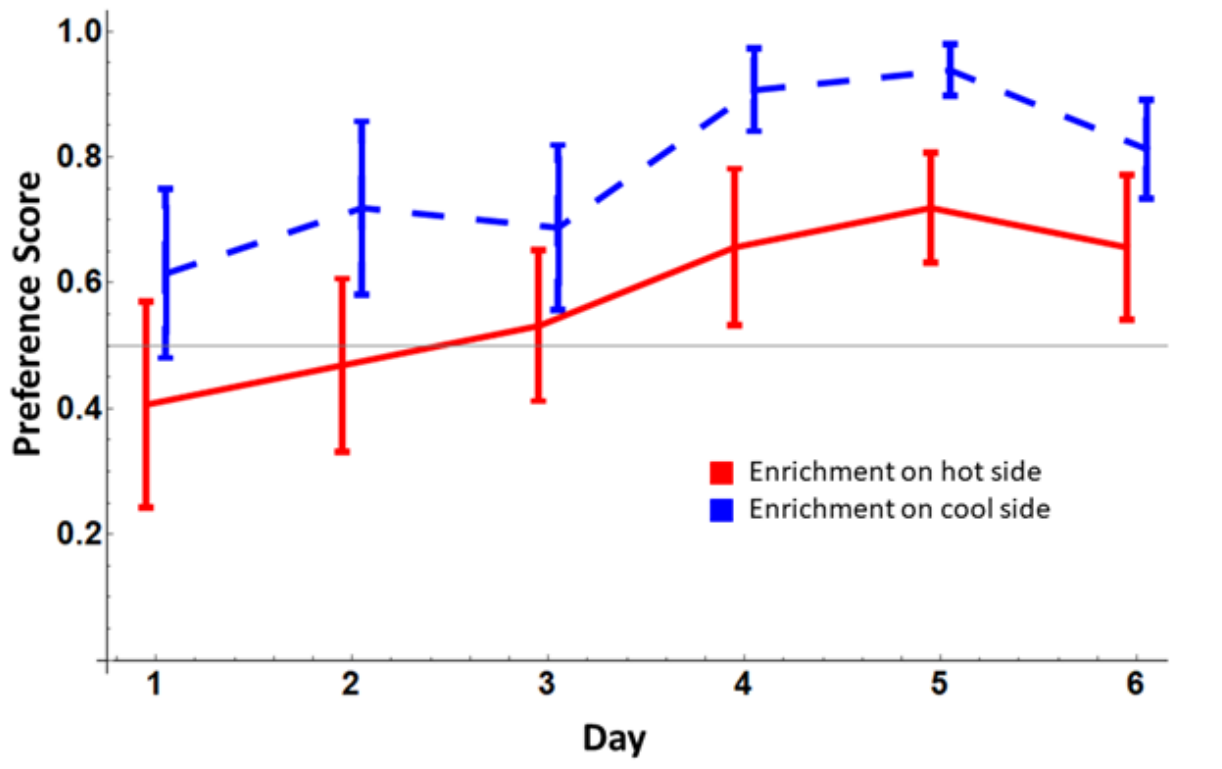
Figure 1. Preference for the enriched side of the enclosure as a function of day (x-axis) and whether the enriched side of the cage was warmer (solid red line) or cooler (dashed blue line). Error bars show ± SEM.